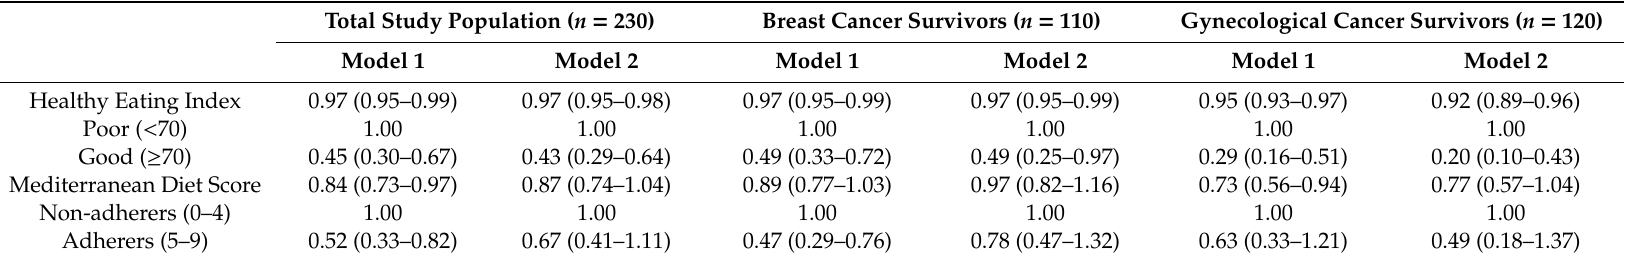
Table 3. The association between diet quality indices and mortality for all participants and according to their cancer diagnosis 1